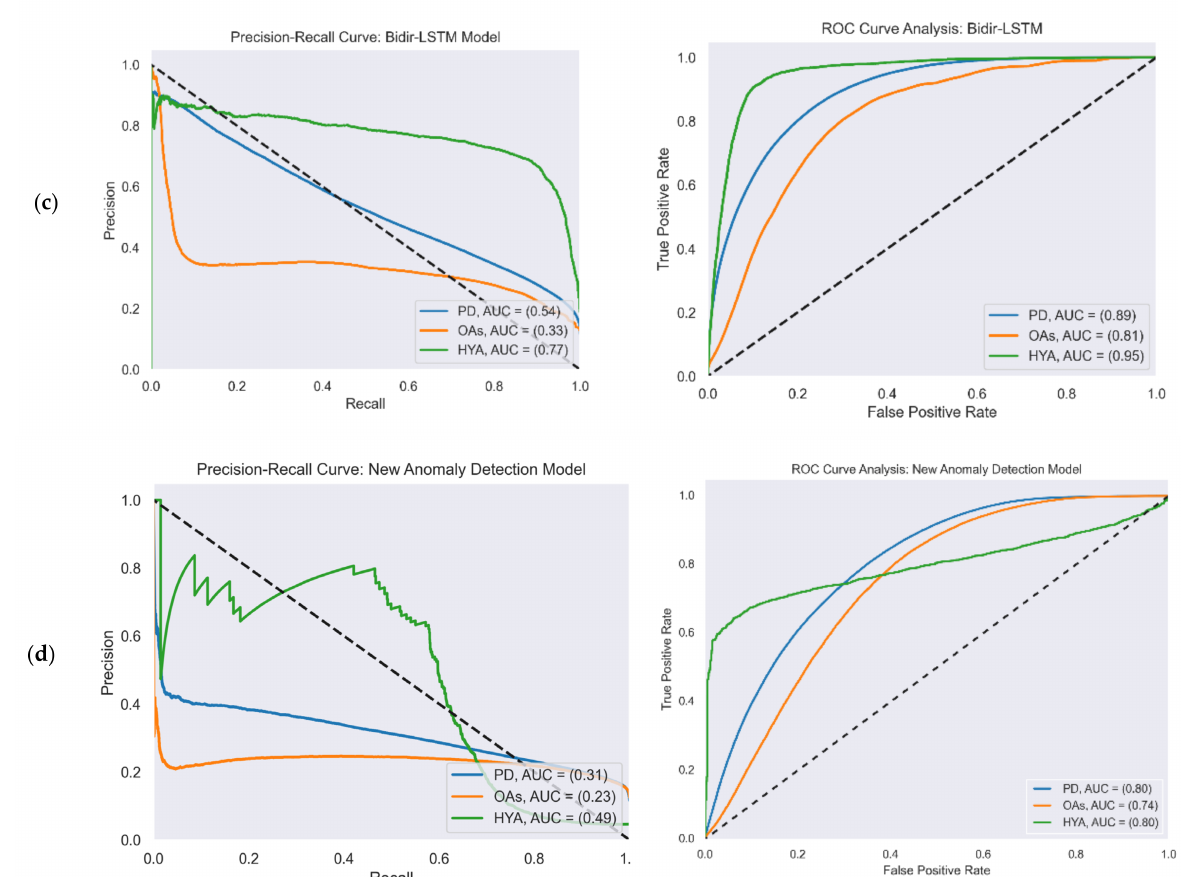
Figure 4. PR (left) and ROC curves (right) illustrate the performance of the four gait detection models with the three study cohorts: PD, OAs, and HYAs: ( a ) PR curve (left) and ROC curve (right) of the AR-iHMM model; ( b ) PR curve (left) and ROC curve (right) of the DCNN model; ( c ) PR curve (left) and ROC curve (right) of the Bidir-LSTM model; ( d ) PR curve (left) and ROC curve (right) of the anomaly detection model.